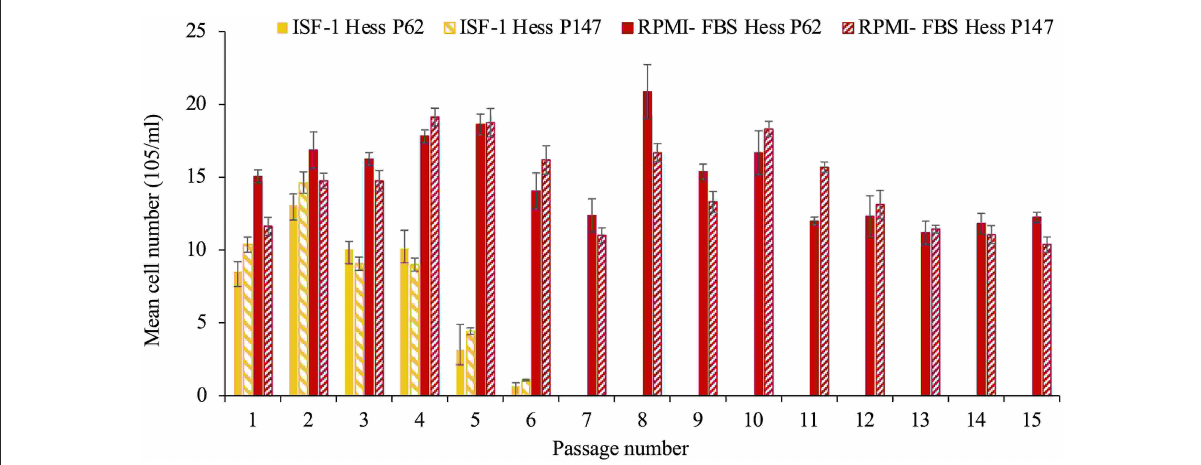
FIGURE2 Growth of T. annulata Hessiene cell culture in RPMI-FBS and ISF-1 for 15 passages starting from passage 62 and passage 147 that were previously frozen in liquid nitrogen and maintained in ISF-1. Bars indicate standard deviation from the mean cell number of each culture replicate.